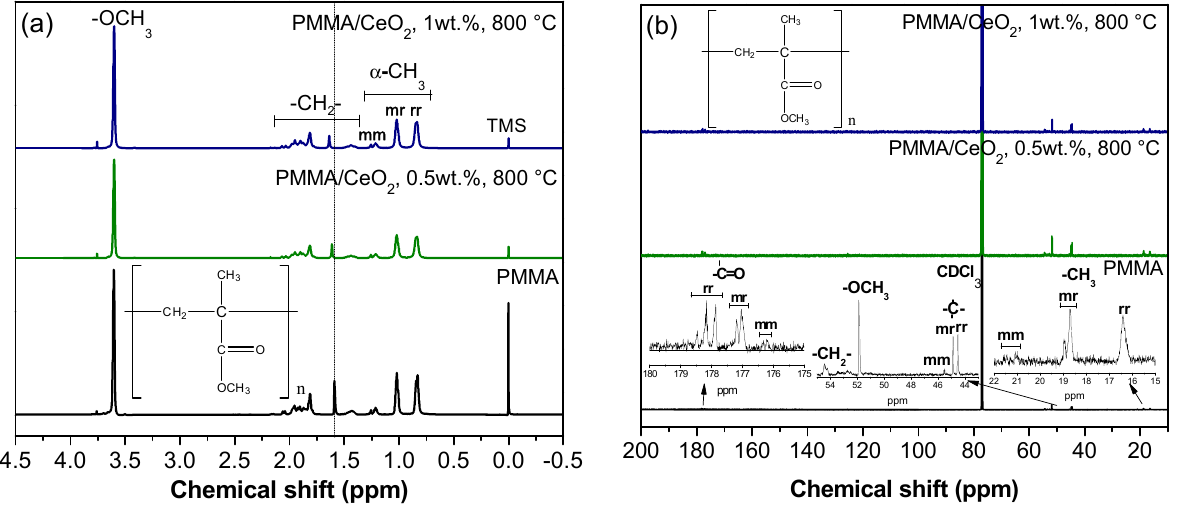
hybrid systems by ( a ) 1 H NMR 2